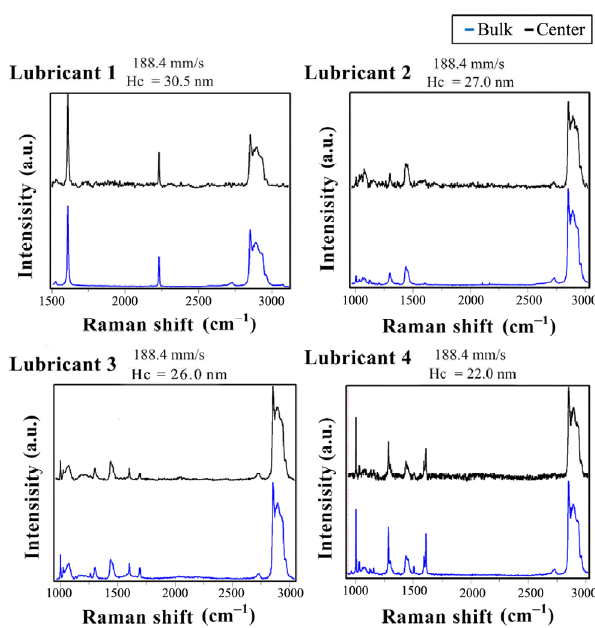
Fig. 8 In situ Raman spectral results for Lubricant 1–4 at different areas and the measured film thickness in the center